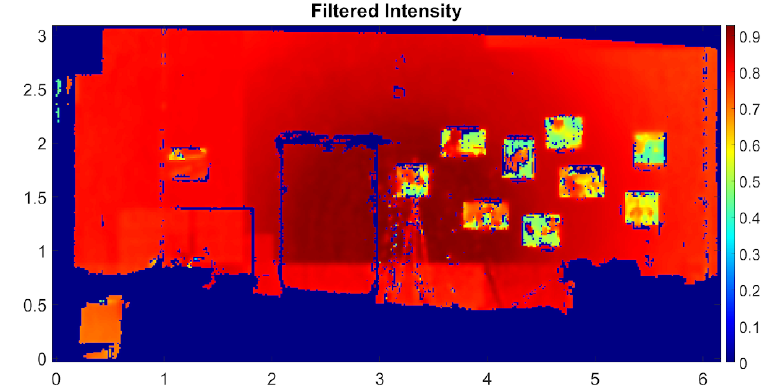
Figure 8. Image of intensity (of reflected laser beams).